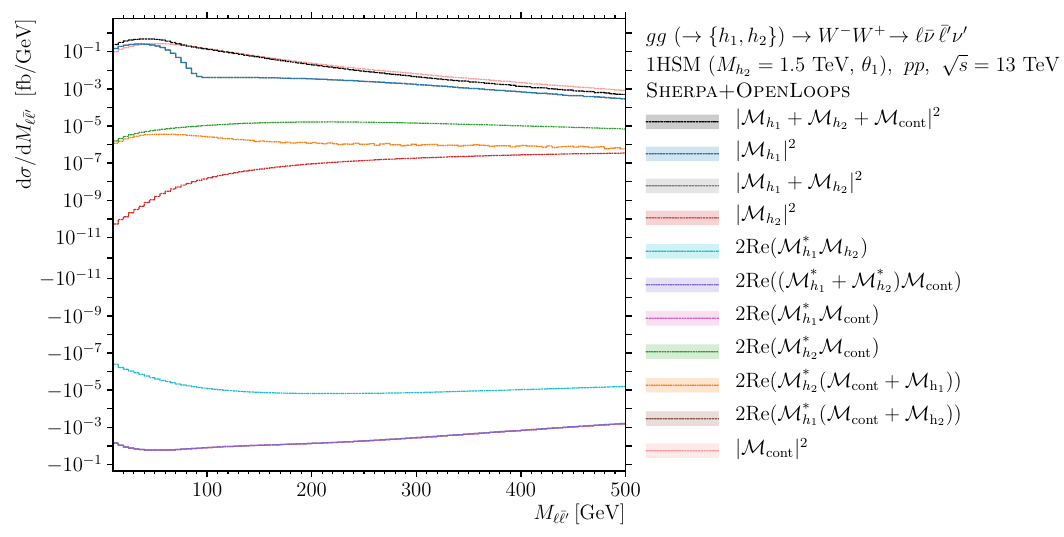
M distributions for the signal process gg ( (cid:31) ¯ (cid:31) (cid:31) = 1500 GeV, θ 1 ) including its interference with the background in pp collisions at the 1HSM ( M h 2 √ s = 13 TeV. Other details as in figure 4.